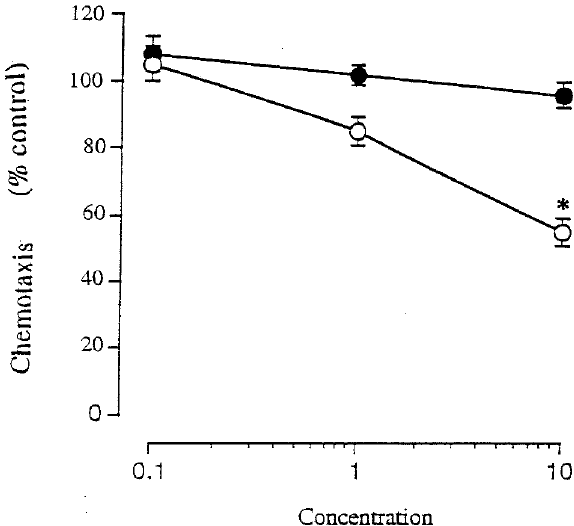
FIG. 3. Inhibitory effects of heparin (U/ml; open circles) and heparan sulphate ( m g/ml; closed circles) on PDGF-induced human lung fibroblast chemotaxis. The responses are expressed as SI. Each point is the average of triplicate values from 3 experiments. Vertical lines represents.e. mean. p < 0.05 when compared with PDGF.